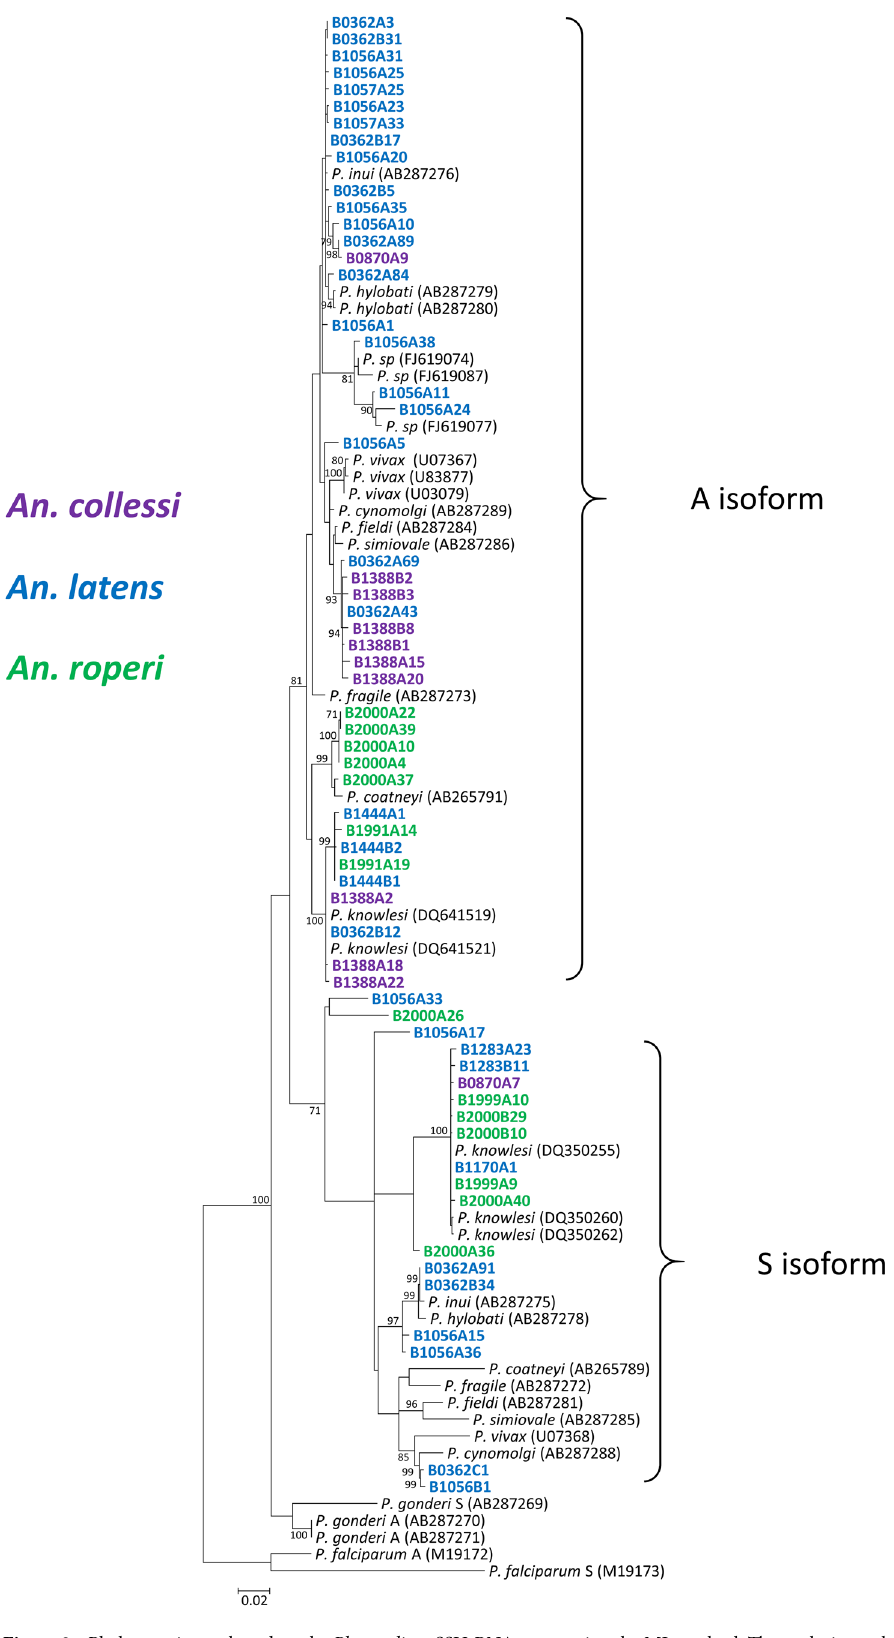
Figure 2. Phylogenetic tree based on the Plasmodium SSUrRNA genes using the ML method. The analysis was based in the Tamura-3 + G + I substitution model. GenBank accession numbers are in brackets and only bootstrap values > 70% are shown at the nodes. Sequences derived from mosquitoes morphologically identified as An. collessi , An. latens and An. roperi are labelled in purple, blue and green respectively. The tree was generated with MEGA 7.0.21 (https:// www. megas oftwa re. net/) 57